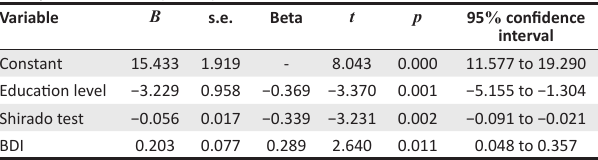
TABLE 4: Results of stepwise multiple linear regression model for the association between biopsychosocial variable and activity limitations related to chronic low back pain in Burundi ( n =